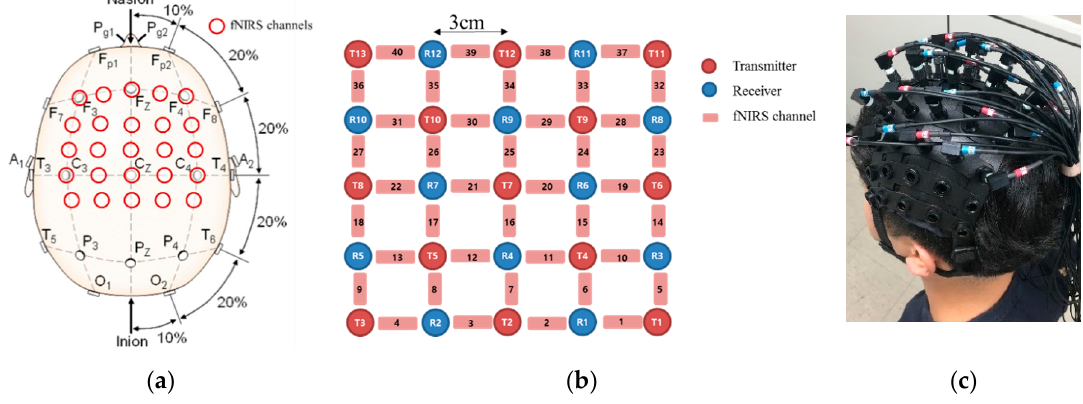
Figure 2. fNIRS channel information: ( a ) channel locations on the brain image; ( b ) schematic diagram of the T- and R-optodes; ( c ) fNIRS cap with 40 wired channels.